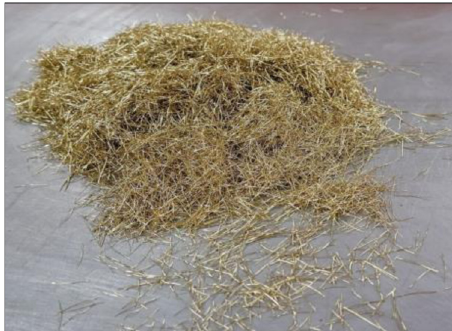
Figure 1: Steel fi bers utilized in this work.